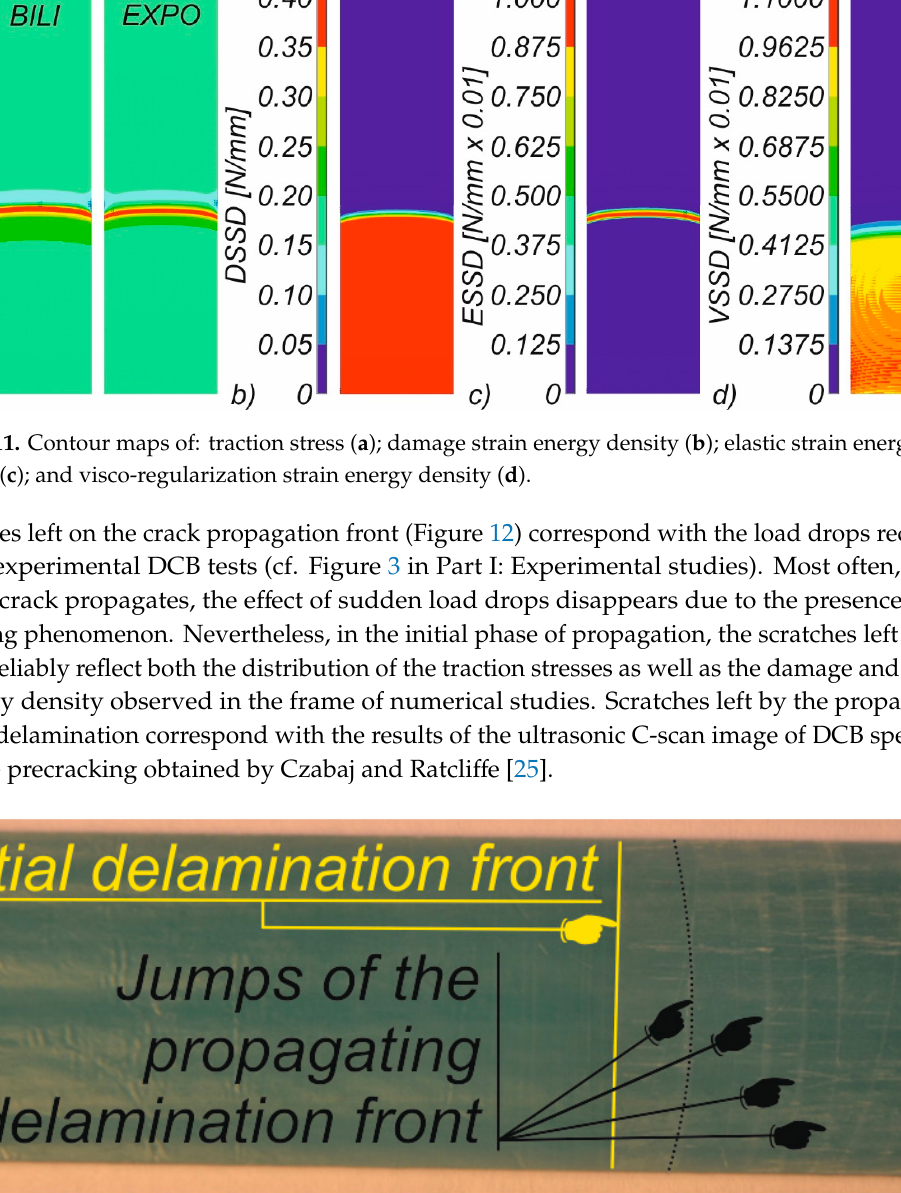
Figure 12. Scratches left by unstable crack propagation during DCB test.